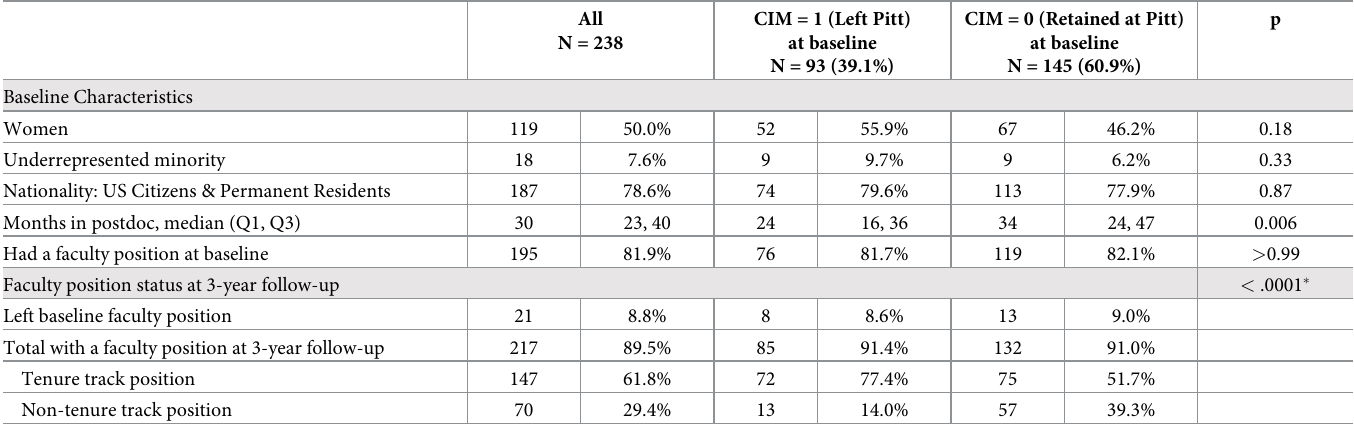
Table 1. Postdoc